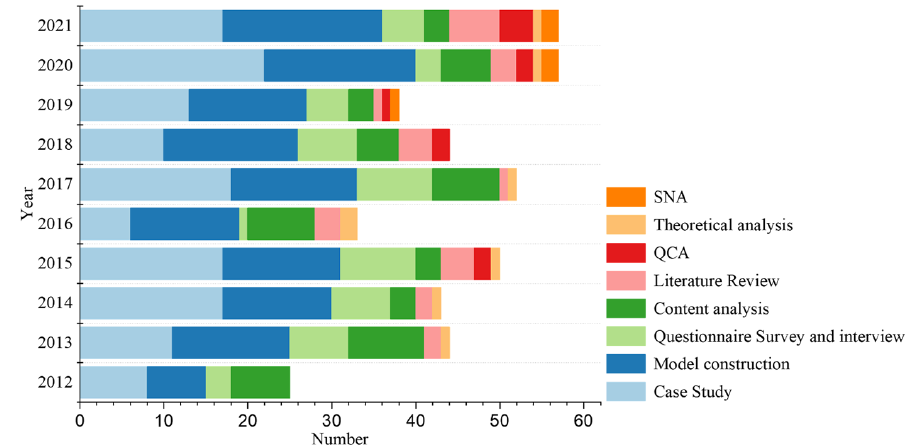
Figure 2. Summary of research